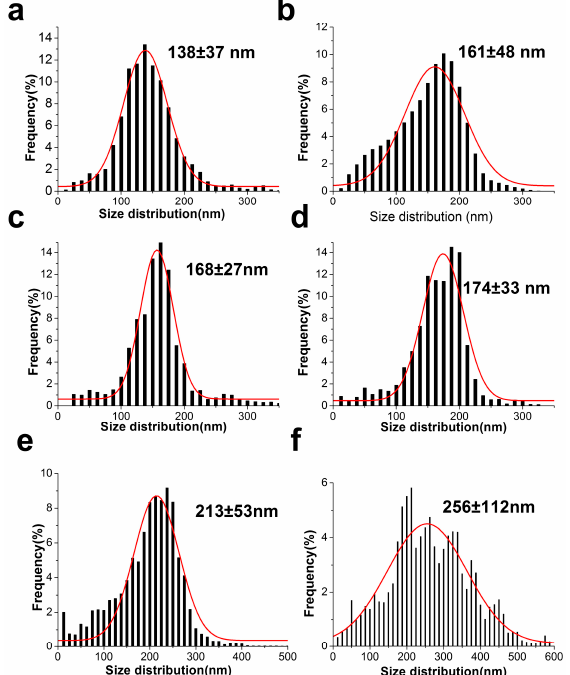
Figure 4. Size distribution and average fiber diameter sizes of pure sol–gel fiber ( a ) and hybrid fibers in which the volume ratios of CL sol–gel solution and PGS solution were 99/1 ( b ); 95/5 ( c ); 90/10 ( d ); 85/15 ( e ) and 80/20 ( f ).